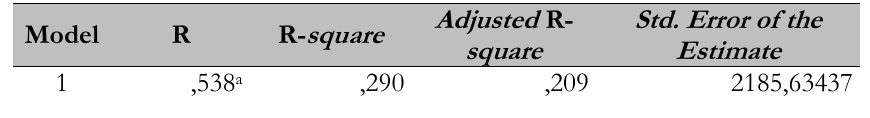
Table 3. Determination